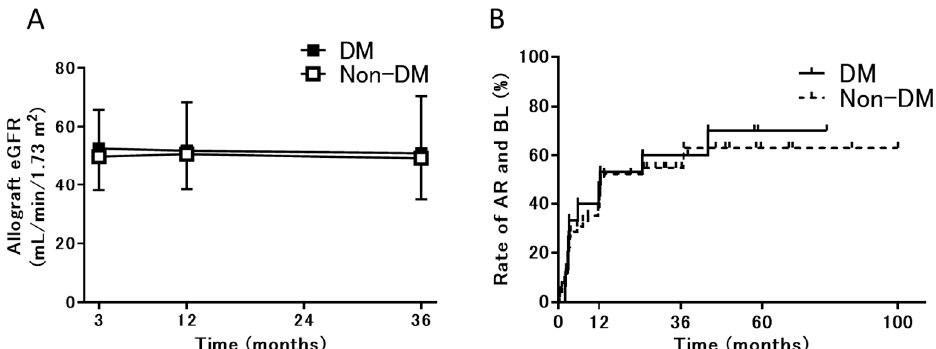
Figure 2. Allograft eGFR and AR incidence in the DM and non-DM groups. ( A ) Allograft eGFR at 3, 12, and 36 months after transplantation and ( B ) the cumulative incidence of AR, including BL. Abbreviations: DM, patients with diabetes; non-DM, patients without diabetes; eGFR, estimated glomerular filtration rate; AR, acute rejection; and BL, borderline change.